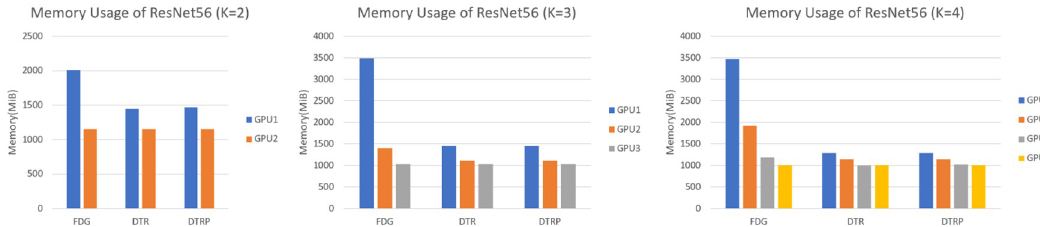
Fig 7. Memory usage of ResNet56 with different K